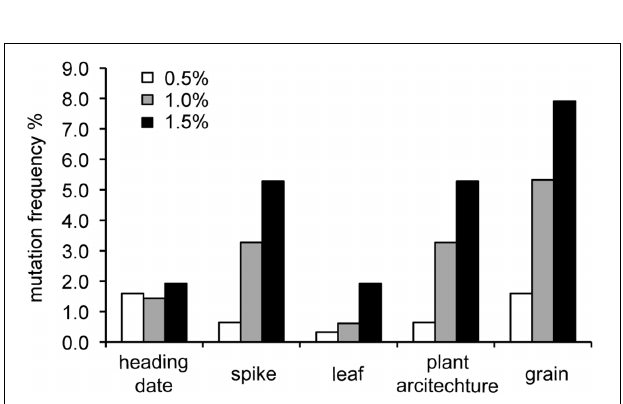
FIGURE 2 | Mutation frequency of each morphological variation category in the three mutagenized wheat populations. Mutations were observed in the heading date, spike, plant architecture, and leaf and grain morphology. Wheat was treated with 0.5% ( n = 313), 1.0% ( n = 489), and 1.5% ( n = 417) EMS to induce mutations. Mutation frequency increased with increased EMS